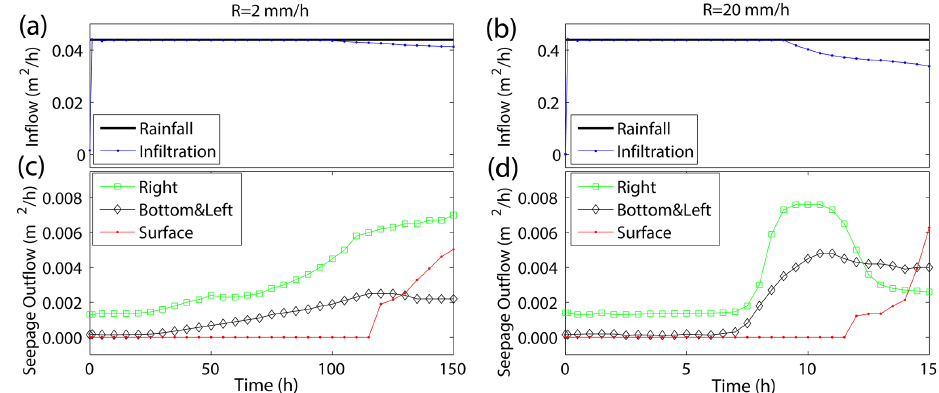
Figure 4. Integrated fluxes for single-permeability model and 2mmh − 1 (left panels) and 20mmh − 1 (right panels) rainfall. Rainfall and infiltration (a, b) , and outflow at the right, outflow at the left and bottom, and outflow at the surface (c, d) .